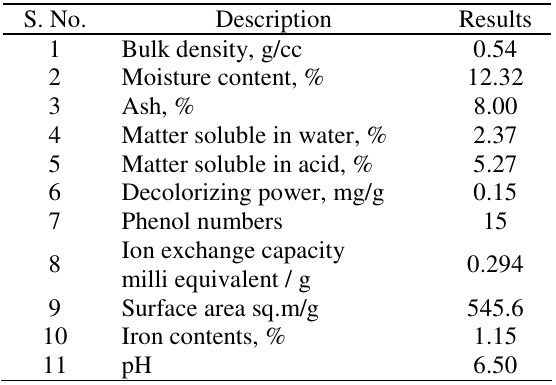
Table 1. Carbon characteristics